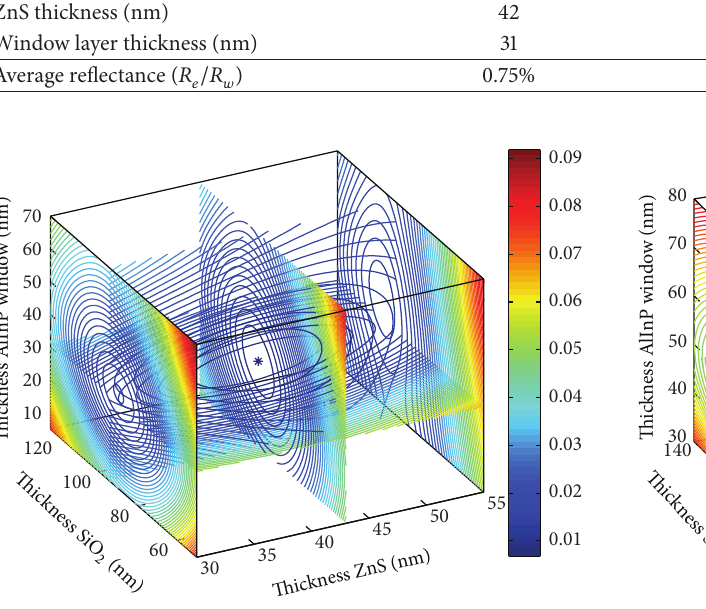
Figure 3: SiO 2 /ZnS ARC 𝑅 𝑤 versus films thickness.